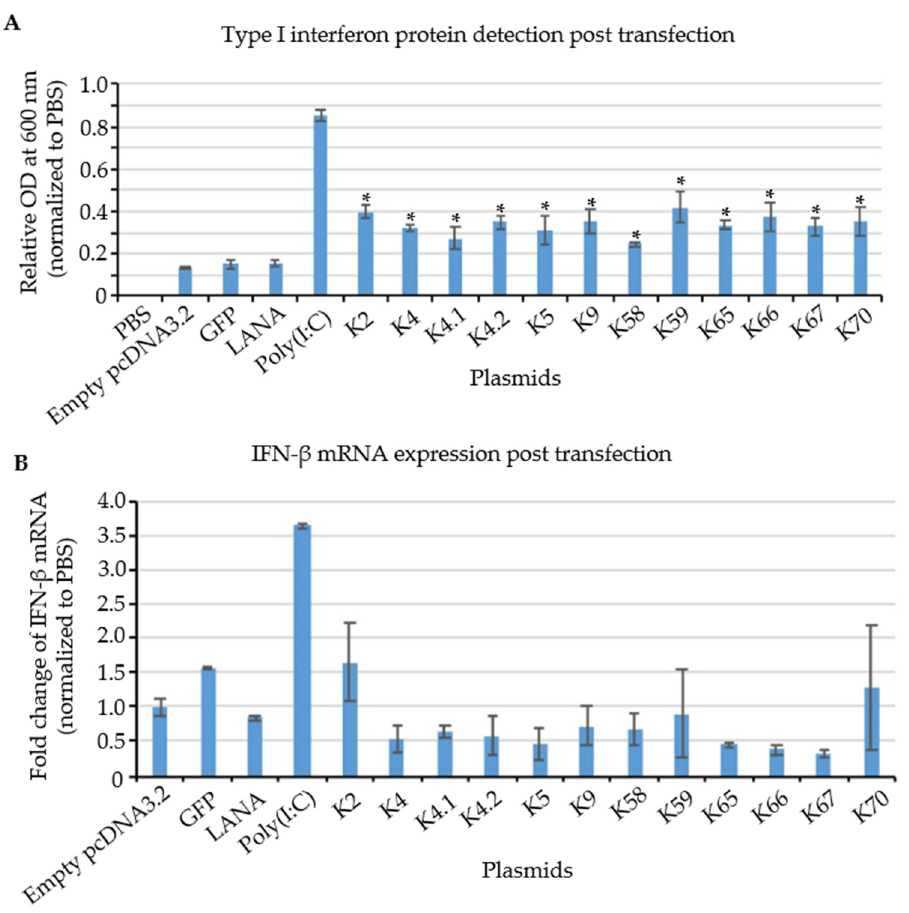
Figure 7. Relative expression of IFN protein and mRNA in KSHV IE and E gene transfected cells. ( A ) IFN protein detection by HEK-blue system. KSHV transcripts and positive control, poly(I:C) showed a significant increase in IFN protein expression, while negative controls, including LANA, GFP, and empty vector showed no change compared to PBS treatment. (n = 3, * p = 0.05) ( B ) RT-qPCR of IFN after 12 h post induction. No significant change was observed in the IFN mRNA among experimental and control groups. (n = 3).